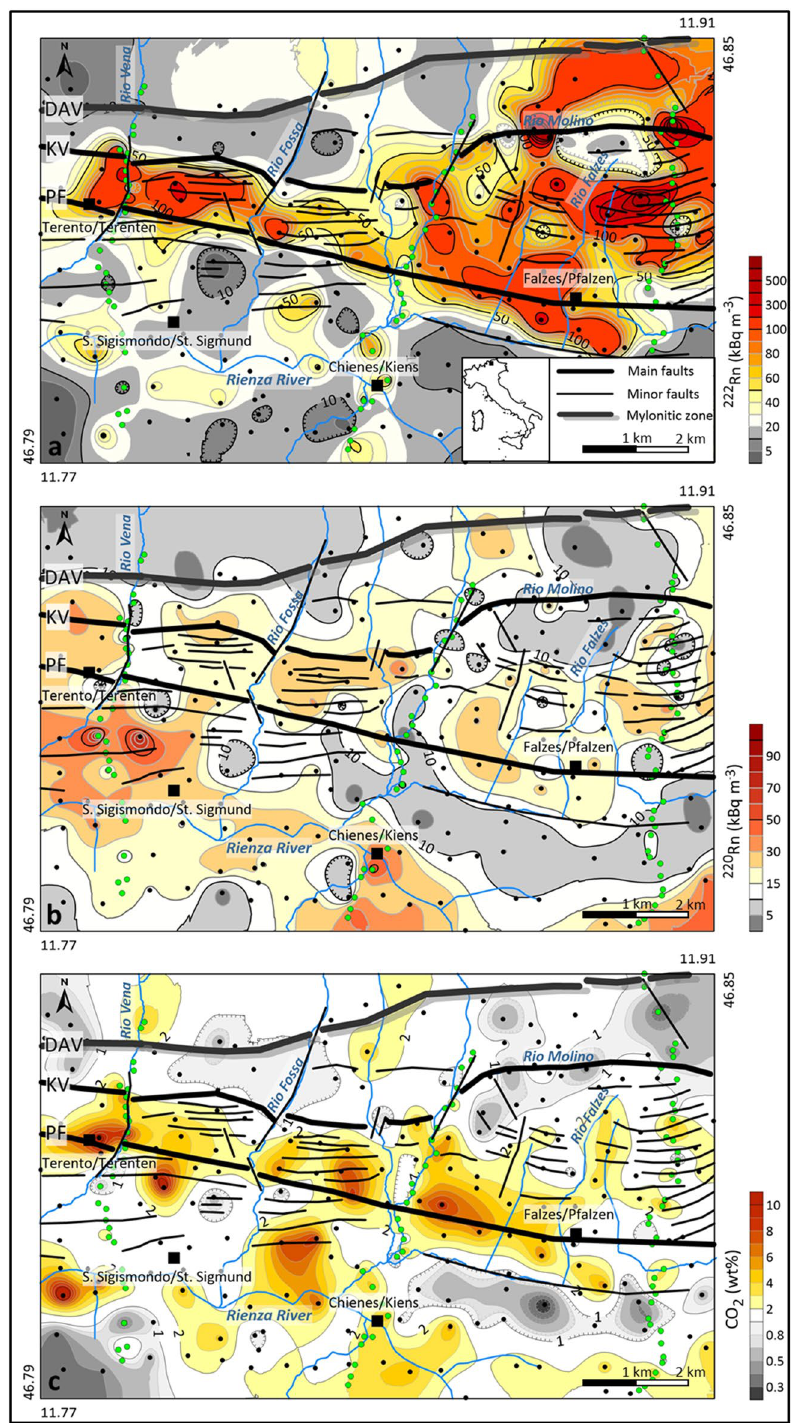
Figure 3. Contour maps of ( a ) 222 Rn, ( b ) 220 Rn and ( c ) CO 2 of the study area. In the maps the structural model of the study area is also reported, with the interpreted structures divided into: main faults (PF = Pusteria/ Pustertal Fault and KV = Kalkstein-Vallarga/Weitental fault); minor faults; Mylonitic zone (DAV = Deffereggen- Anterselva/Antholz-Valles/Vals mylonitic zone). The coloured points represent the location of the soil-gas measurements: areal sampling in black and the three profiles (P1, P2, P3) in